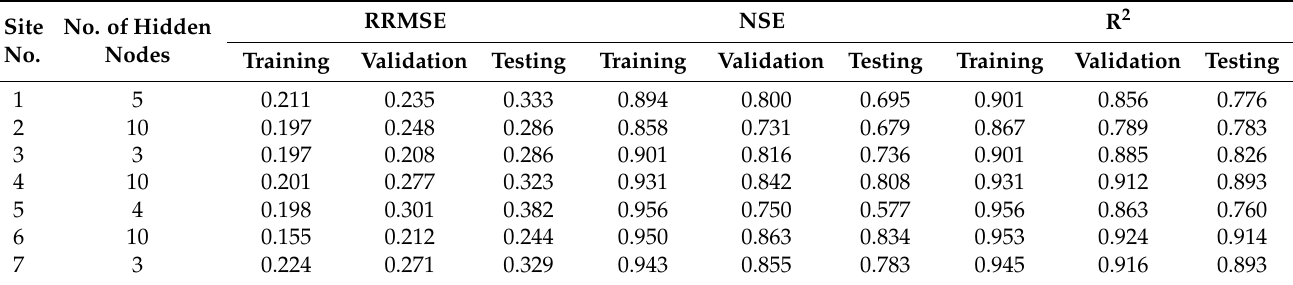
Table 3. Performance statistics of the optimal ANN-1.